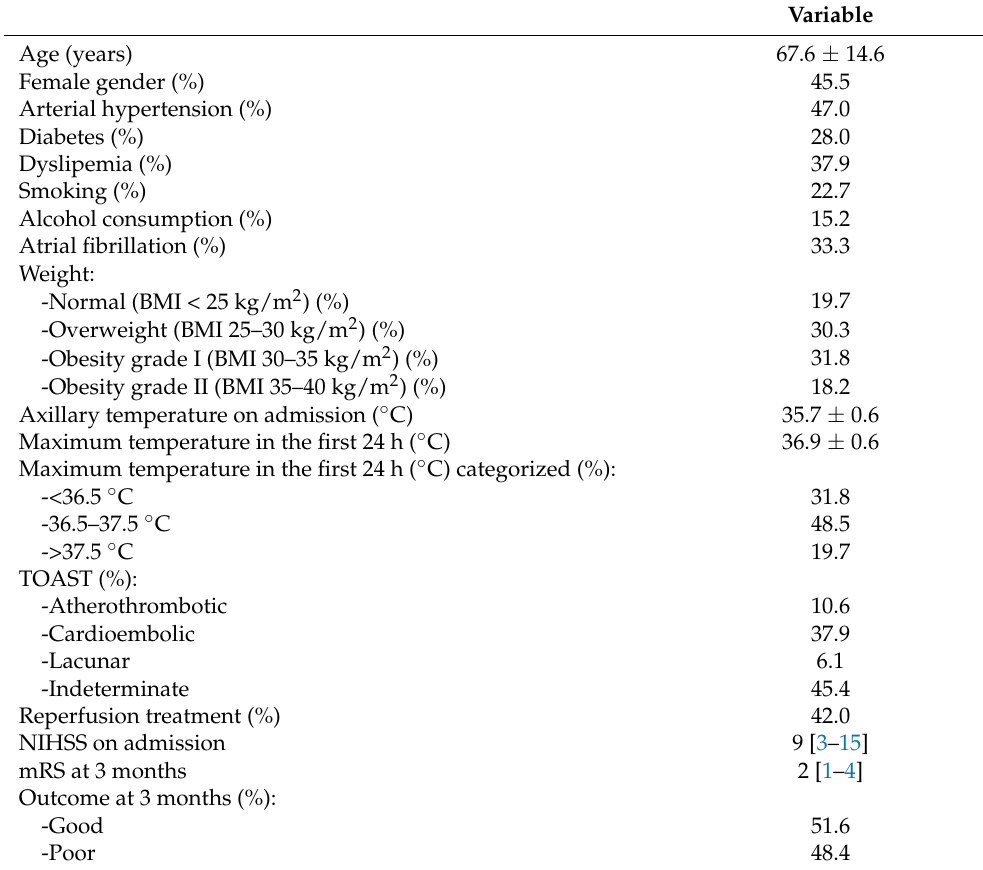
Table 1. Description of the 66 obese stroke patients analyzed in the present work. BMI: body